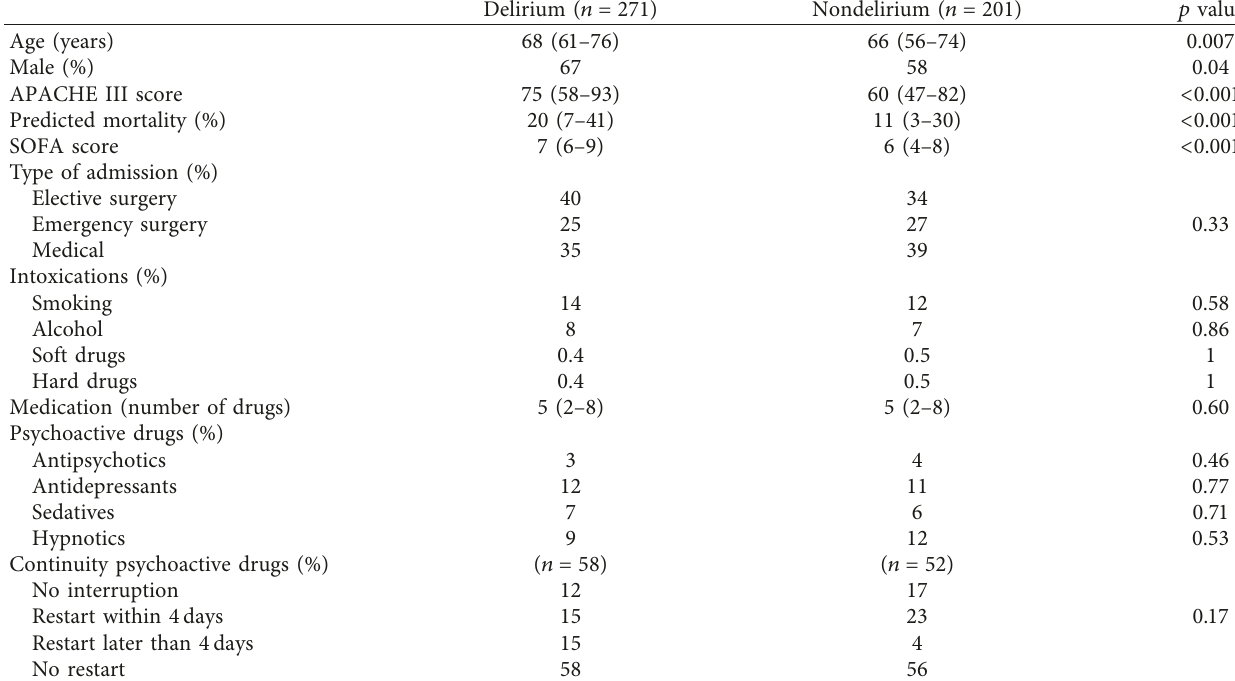
Table 3: Secondary analysis: baseline